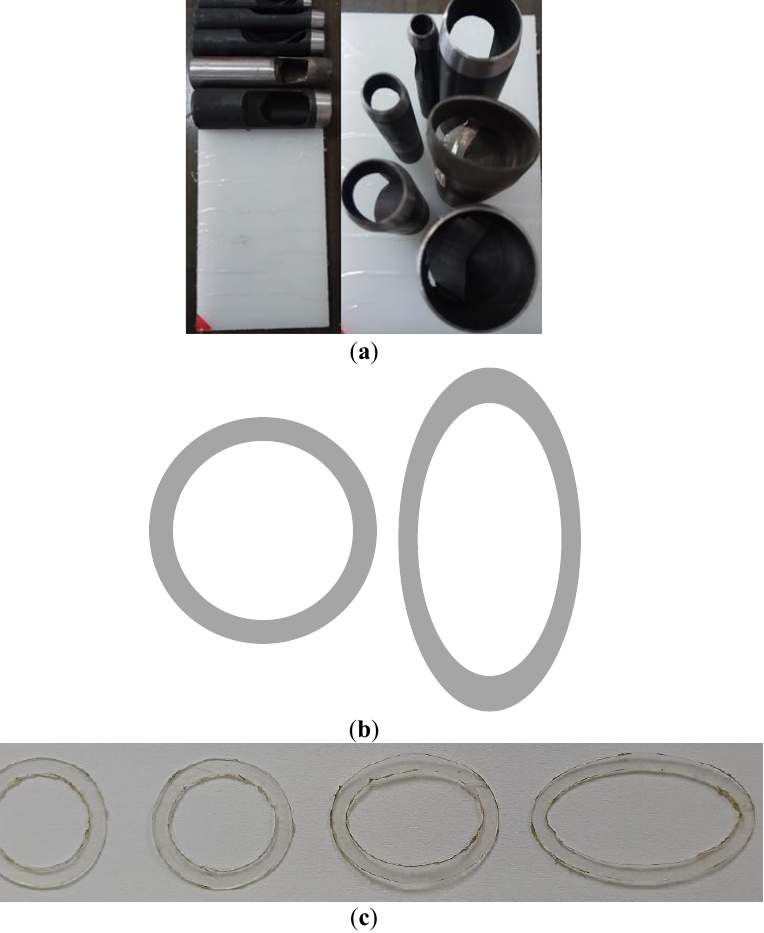
Figure 5. PET film gaskets with different sizes and punchers. ( a ) Photograph of punchers; ( b ) schematic diagram of gaskets; ( c ) photograph of gaskets.